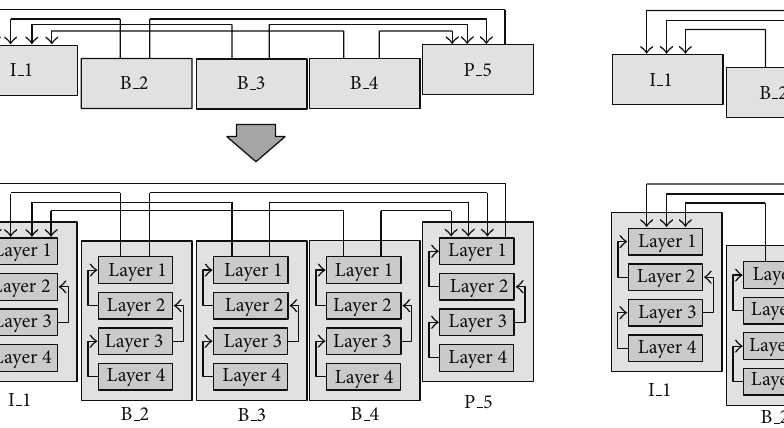
Figure 4: MP4 scalable streaming scheme. Figure 5: H.264 scalable streaming